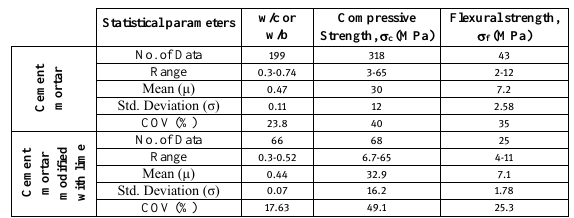
Table 4: Statistical parameters of the properties of cement mortar